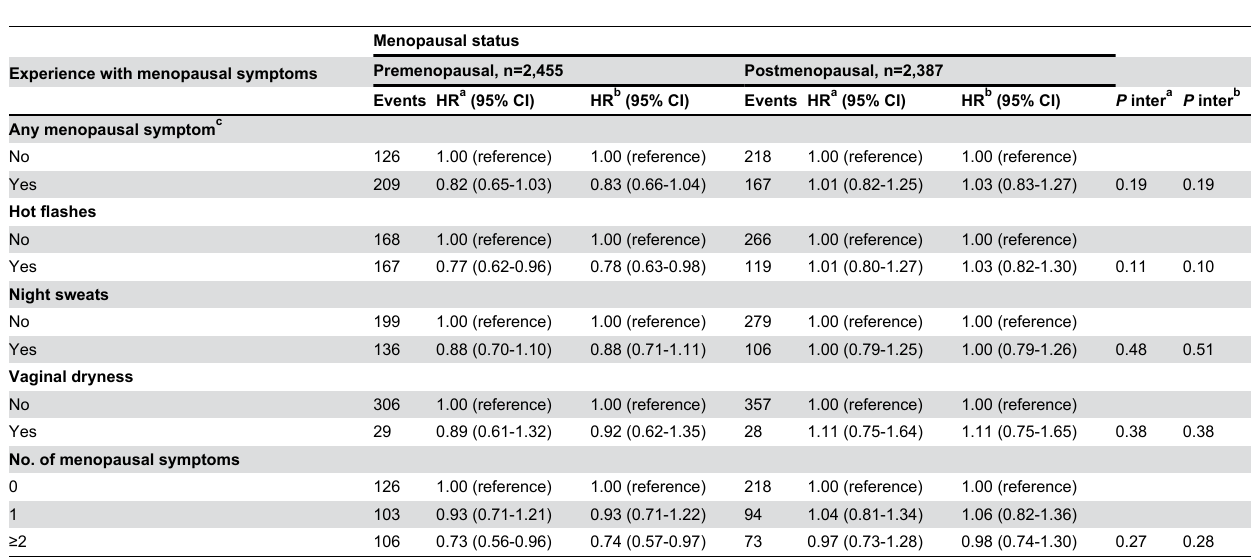
Table 2. Postdiagnosis menopausal symptoms in association with breast cancer recurrence by menopausal status, SBCSS